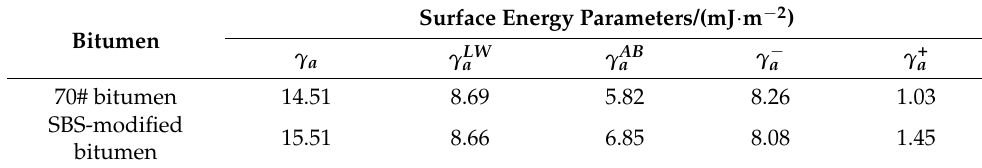
Table 7. Bitumen surface energy parameters.